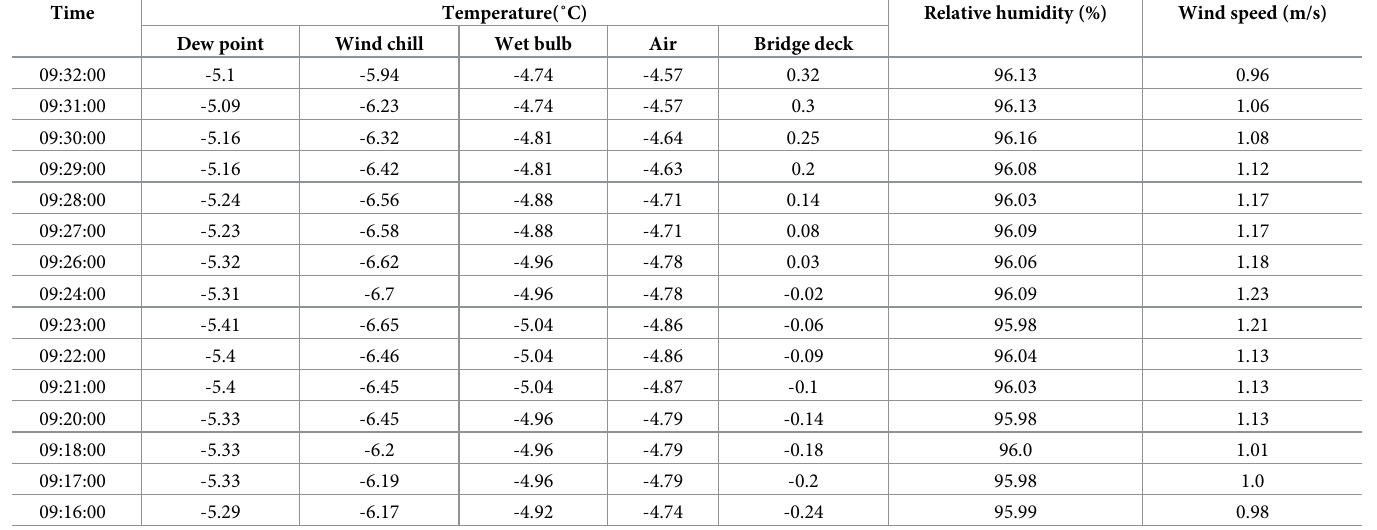
Table 1. Meteorological data of Tuhai River